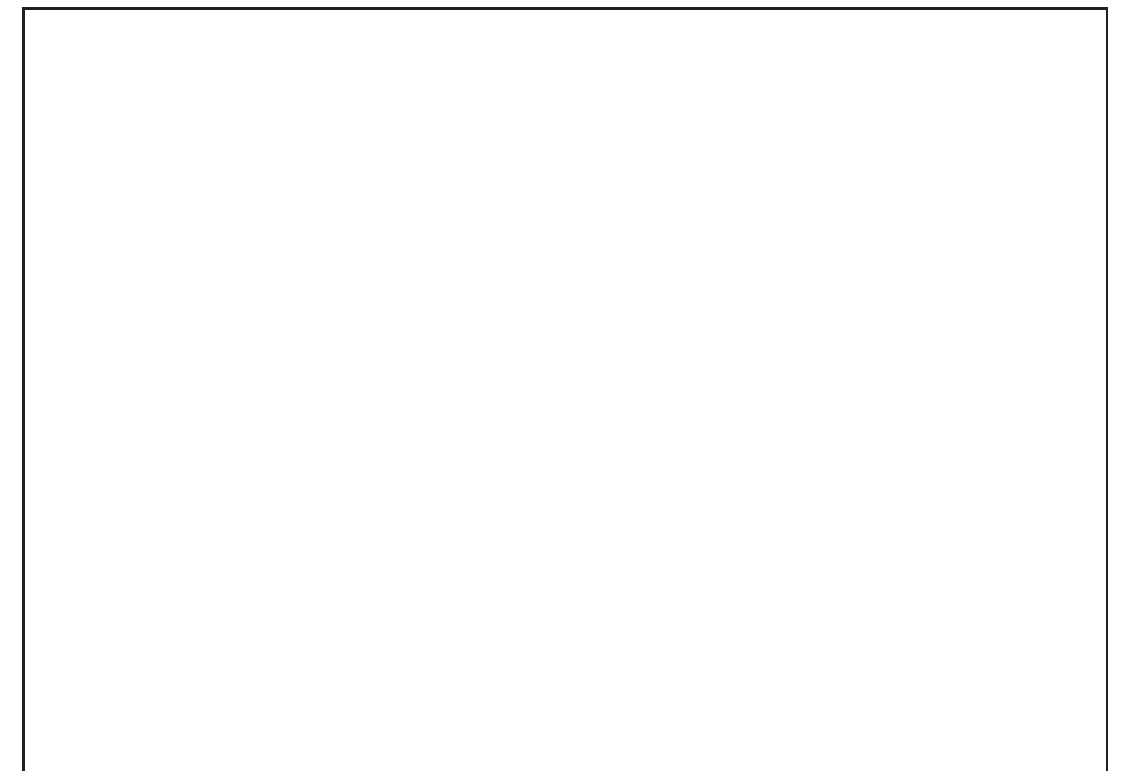
Fig. 1: Yellowish hyper keratotic papules over the lower right 2 nd